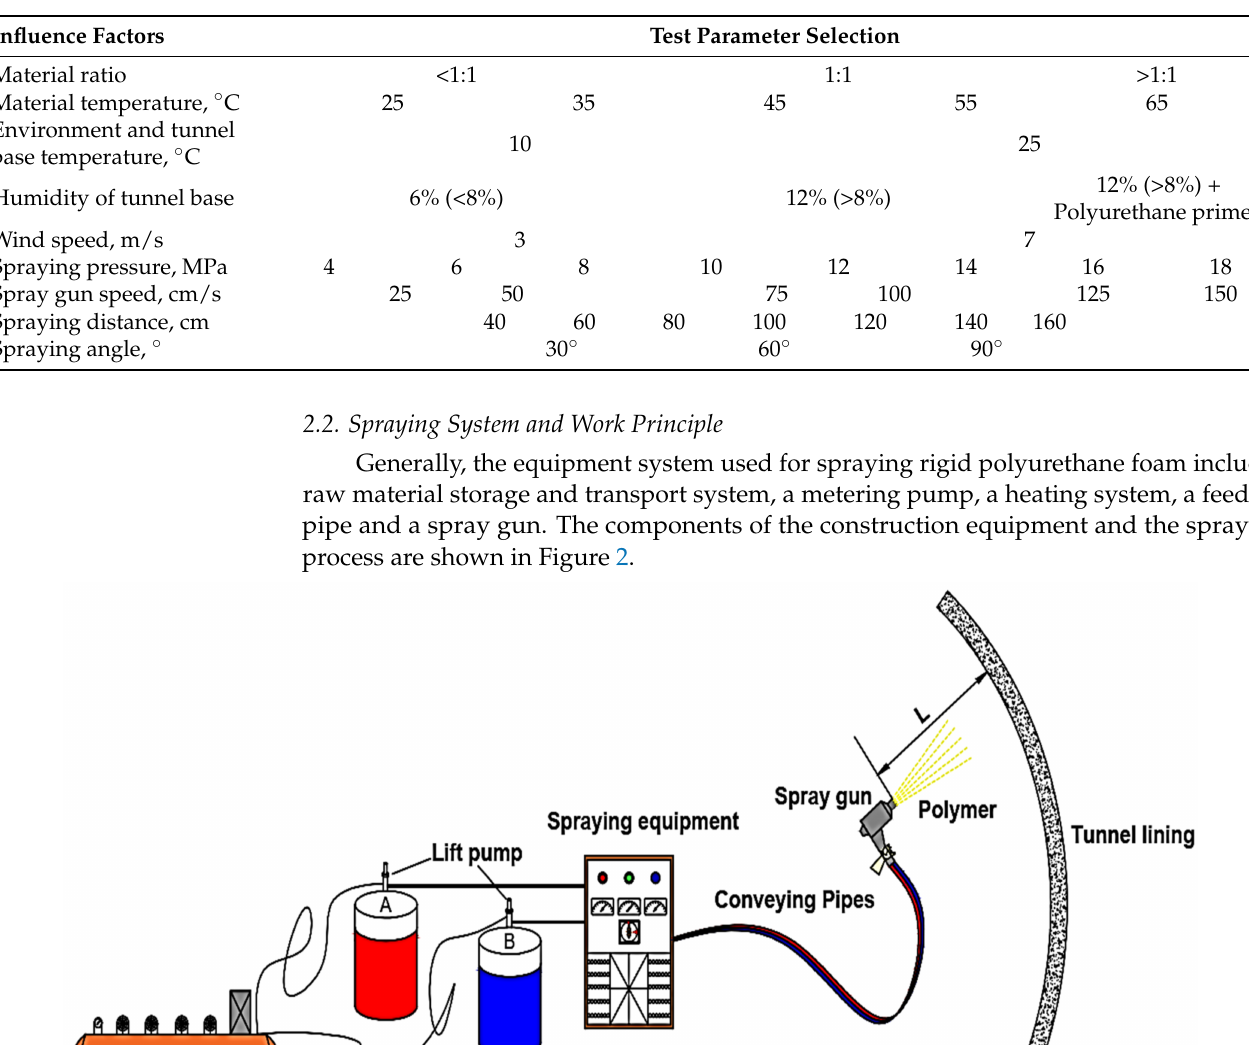
Table 1. Scheme of spraying test of the polymer and parameter selection.